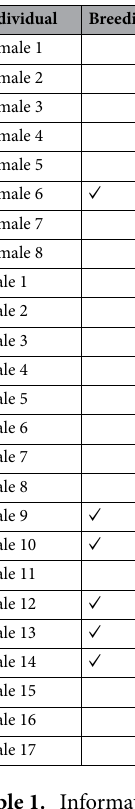
Table 1. Information of study animals. a Moved on July 17,